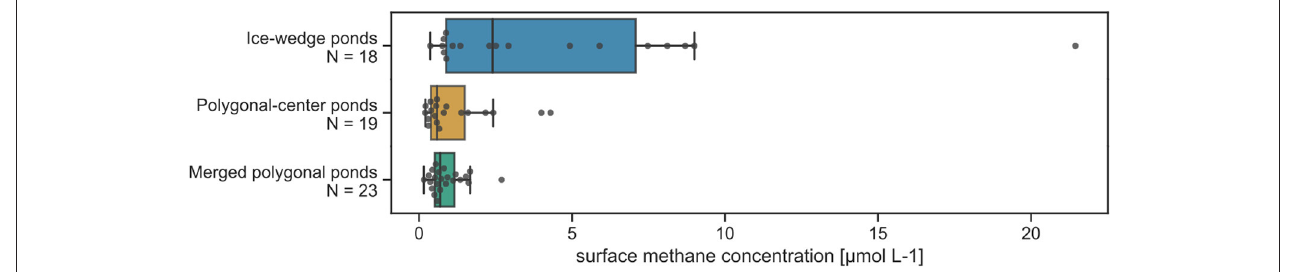
FIGURE 4 | Distribution of surface concentrations separated by pond type. Boxplots with median as well as all data points are displayed. Number of measurements (N) is stated next to each boxplot.